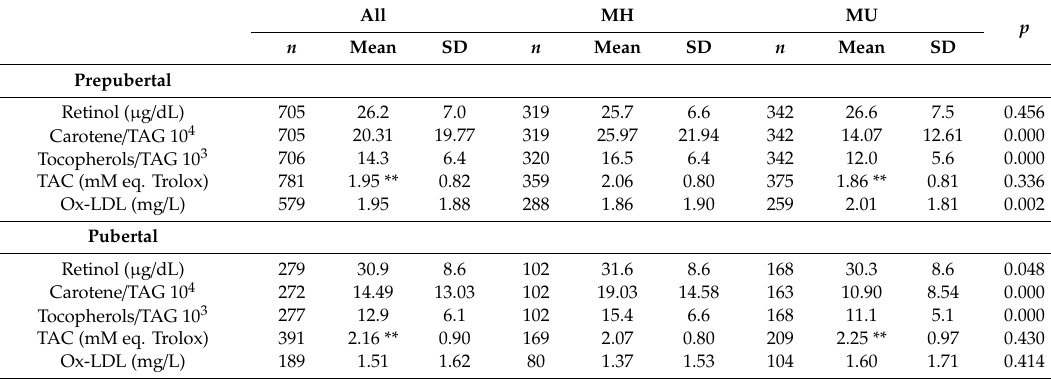
Table 1. Plasma antioxidant and oxidative stress biomarkers according to metabolic health and pubertal status. All